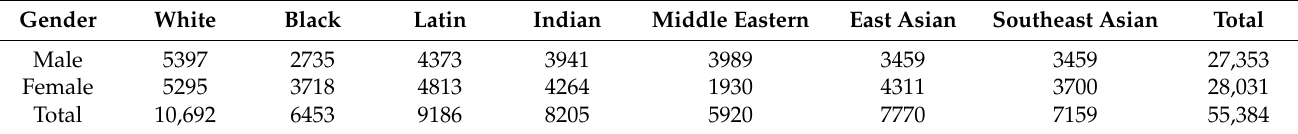
Figure 6. Representation of ethnicities in FairFace ( left ) and FairFace filtered ( right ). Gender representation in the initial dataset was at 53% male face images versus 47% female face images. The ratio between the representation of male and female facial images in the FairFace filtered is 49.4% versus 50.6%. With the FairFace set, it can be noticed that by filtering, the set actually balanced even better in the general ratio of male and female face images (Table 6). Table 6. Overview of image distribution in FairFace filtered